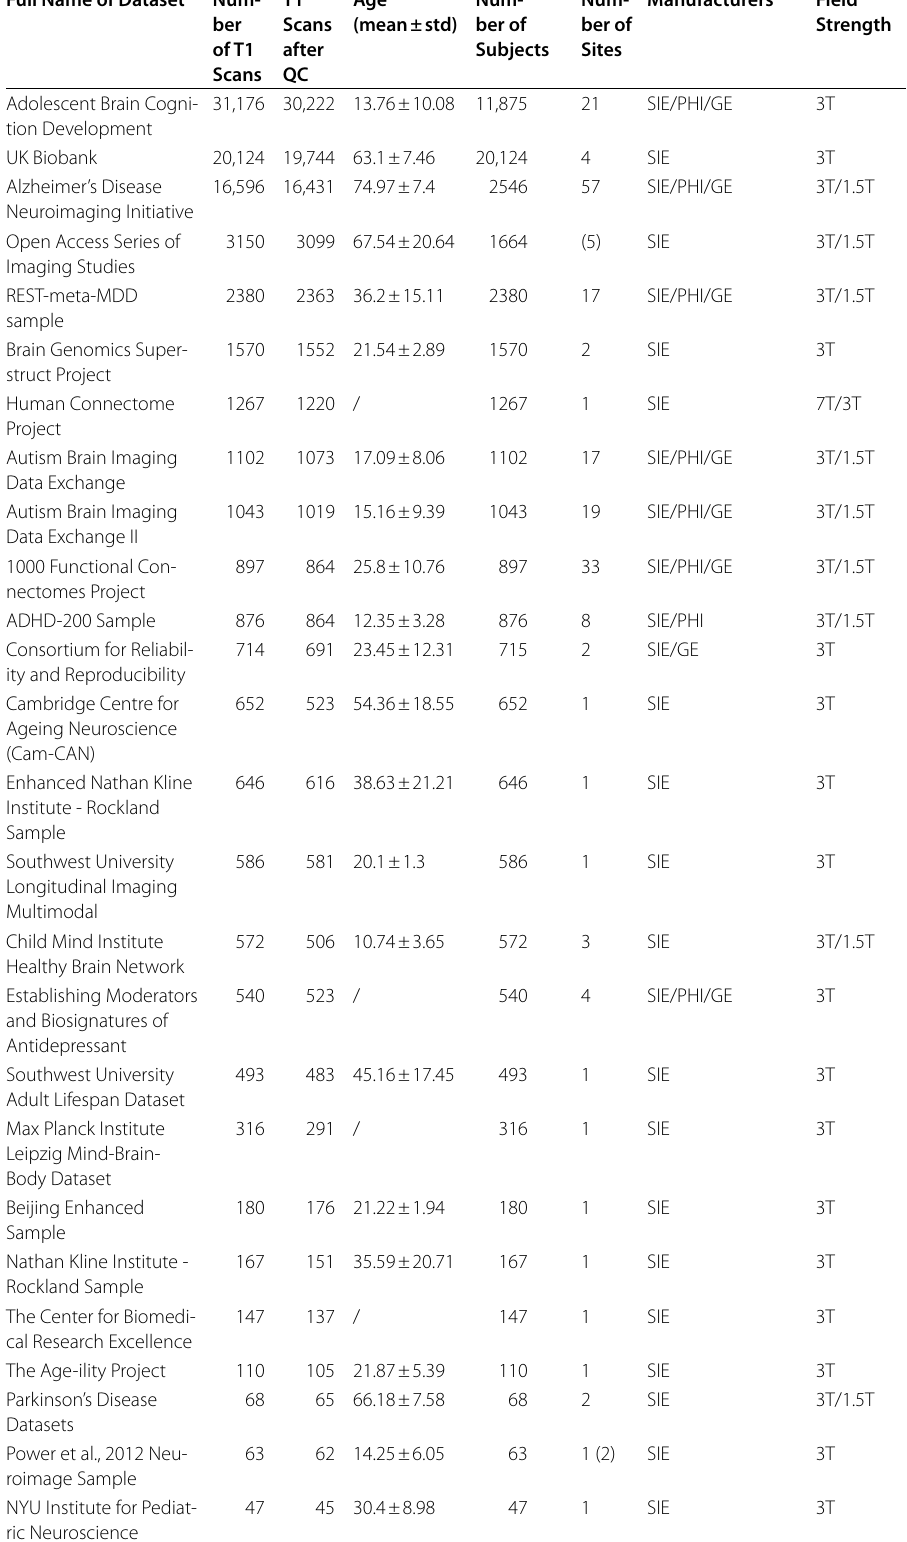
Table 1 Datasets used in the present